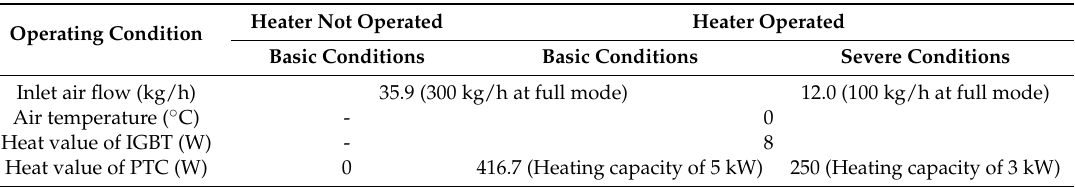
Figure 6. Analysis model of the heat interference with the controller. Table 5. Boundary conditions for heat flow analysis of the controller-integrated high-voltage PTC heating system.